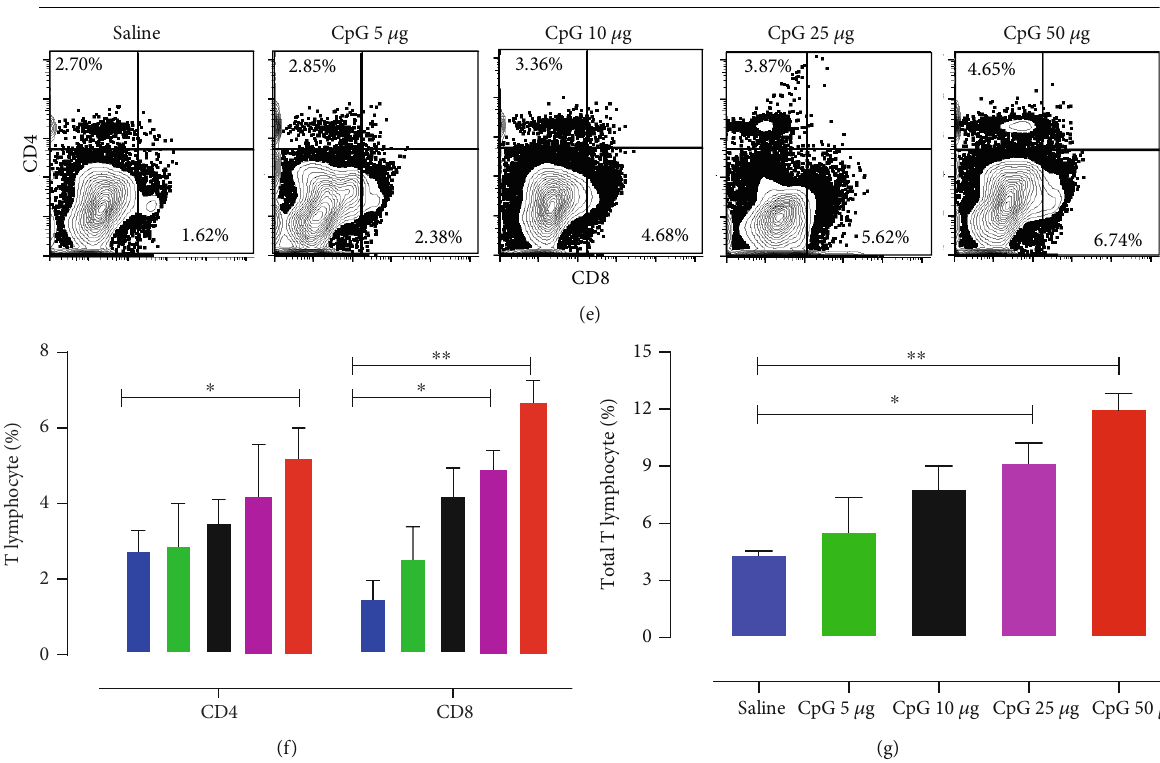
Figure 3: CpG-ODN induced a dose-dependent enrichment of splenic immunological niches. CpG-ODN treatment resulted in an increase in the number of in fi ltrating antigen-presenting cells and T lymphocytes in the spleen. Flow cytometric analysis of splenocytes at 72hrs post in ovo injections (day 21 embryo) ( n = 3 ‐ 4/group ). Cells were plotted based on forward and side scatters to gate monocyte/macrophage populations. Then, using PE-labeled mouse anti-chicken monocyte/macrophage (clone: KUL01) and AF488-labeled mouse MHC II monoclonal antibodies, the double-positive population was gated to quantify the number of APCs (dot plot panels, a). Bar diagrams (b) show the means of the total percentage of MHC II + APC in various groups. Histogram panels (c) indicate the level of CD40 expression on MHC II + APCs (the MFI is indicated). Black histogram=isotype control, blue=saline, and red =CpG-ODN treated. Bar diagrams (d) show the means of MFI of CD40 expression on MHC II + APC (vertical line and horizontal bar show the standard error of mean-SEM), n = 3 ‐ 4 . Dunnett ’ s test following ANOVA testing was used to test for signi fi cant di ff erences between CpG-ODN doses and the saline control group. Asterisks indicate groups that were signi fi cantly di ff erent from the control group ( P < 0 : 05 ). (MFI — geometric mean fl uorescence intensity). (e – g) Flow cytometric analysis of the spleen T-cell populations in each group ( n = 3 ‐ 4 ) at 72hr post in ovo injections (day 1 hatch). CD4 + and CD8 + T-cells in the spleen (dot plot panels, e) were quanti fi ed using PE-labeled mouse anti-chicken CD4 and FITC-labeled mouse anti-chicken CD8 monoclonal antibodies. Bar diagrams show CD4 + and CD8 + T-cell number in the spleen (f), and the total number of CD4 + T-cells and CD8 + T-cells combined (g) in various groups. Two-way ANOVA following the Bonferroni posttest was done when CD4 + and CD8 + cells were compared between CpG-ODN received groups and saline control. and the saline control group. Vertical line and horizontal bar show the standard error of mean-SEM. Asterisks indicate groups that